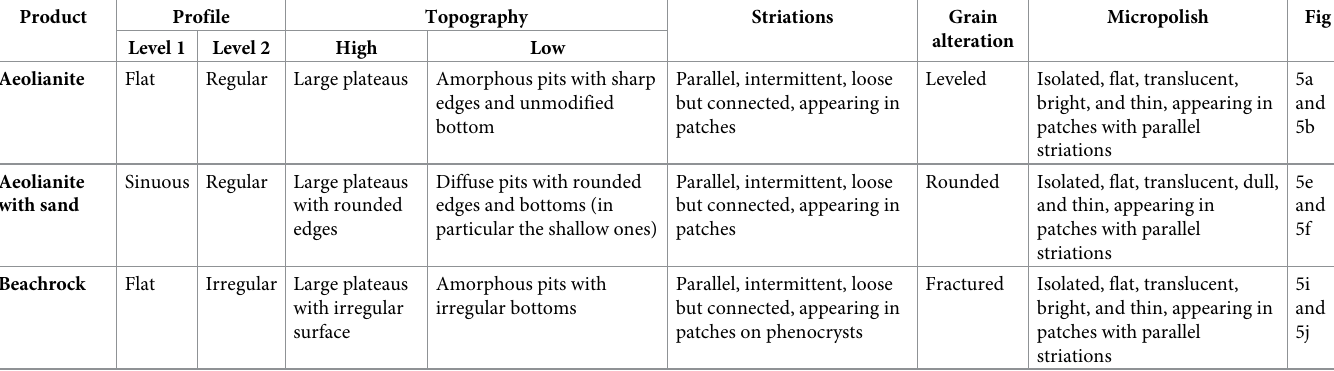
Table 3. Description of traces produced in the first abrasion experiment (detailed in Table 2).